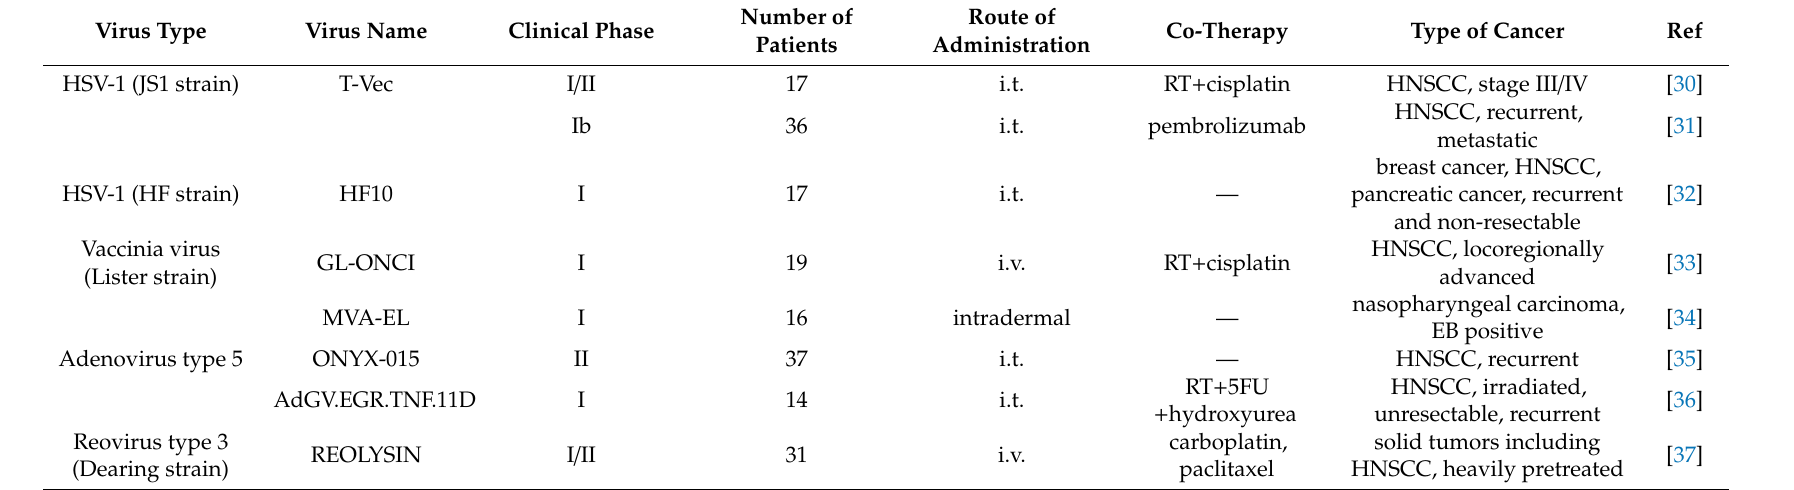
Table 1. Clinical trials of oncolytic virotherapy for